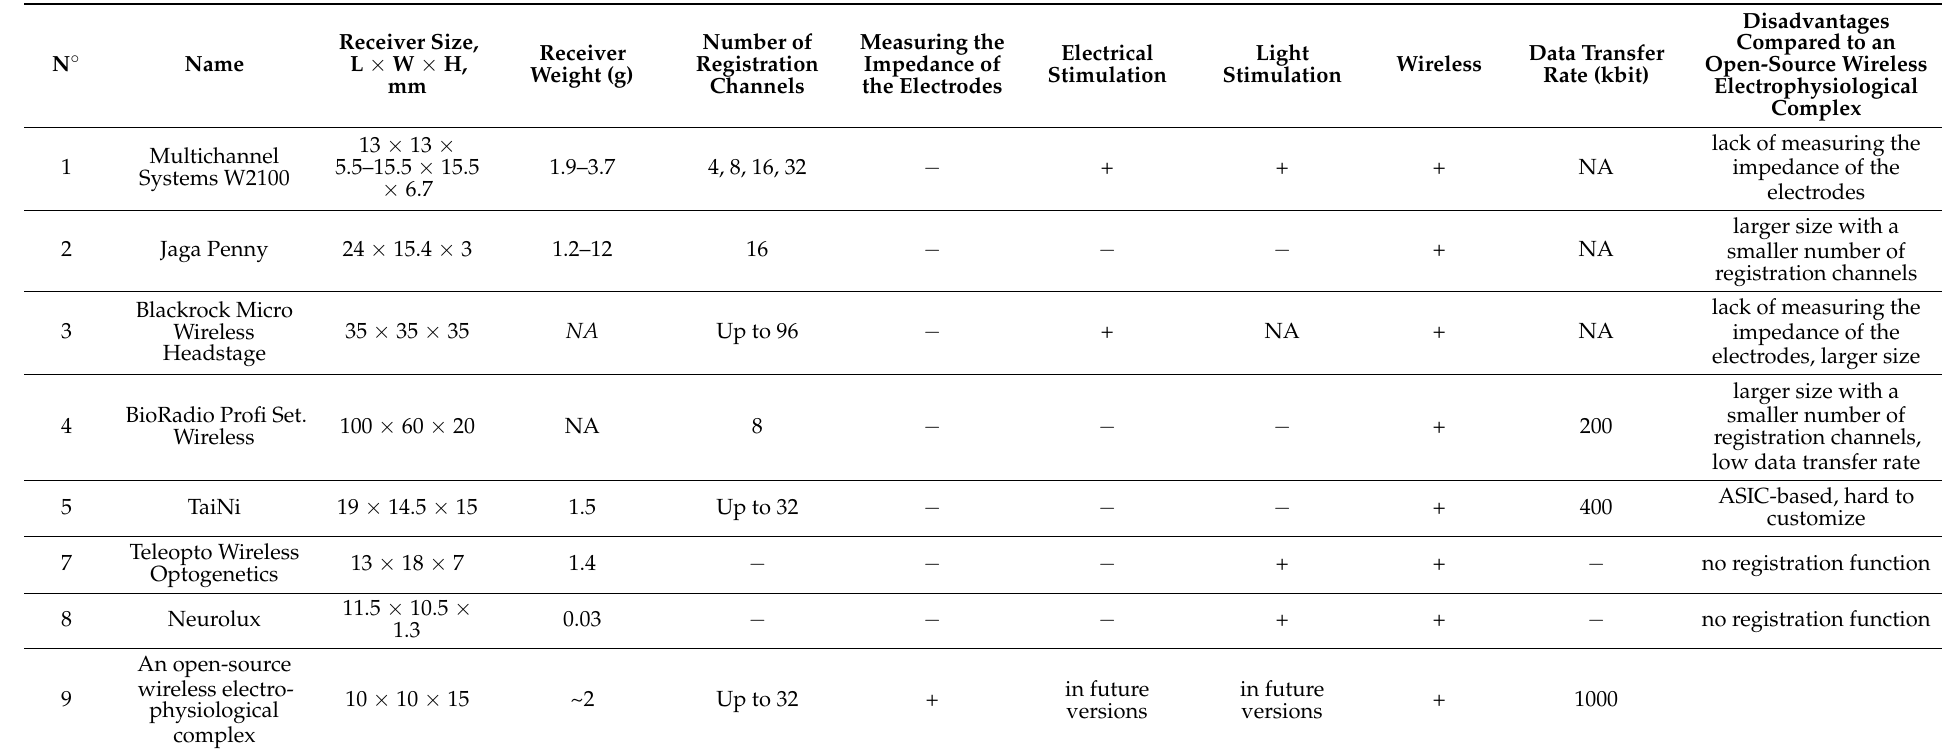
Table 1. In vivo data acquisition